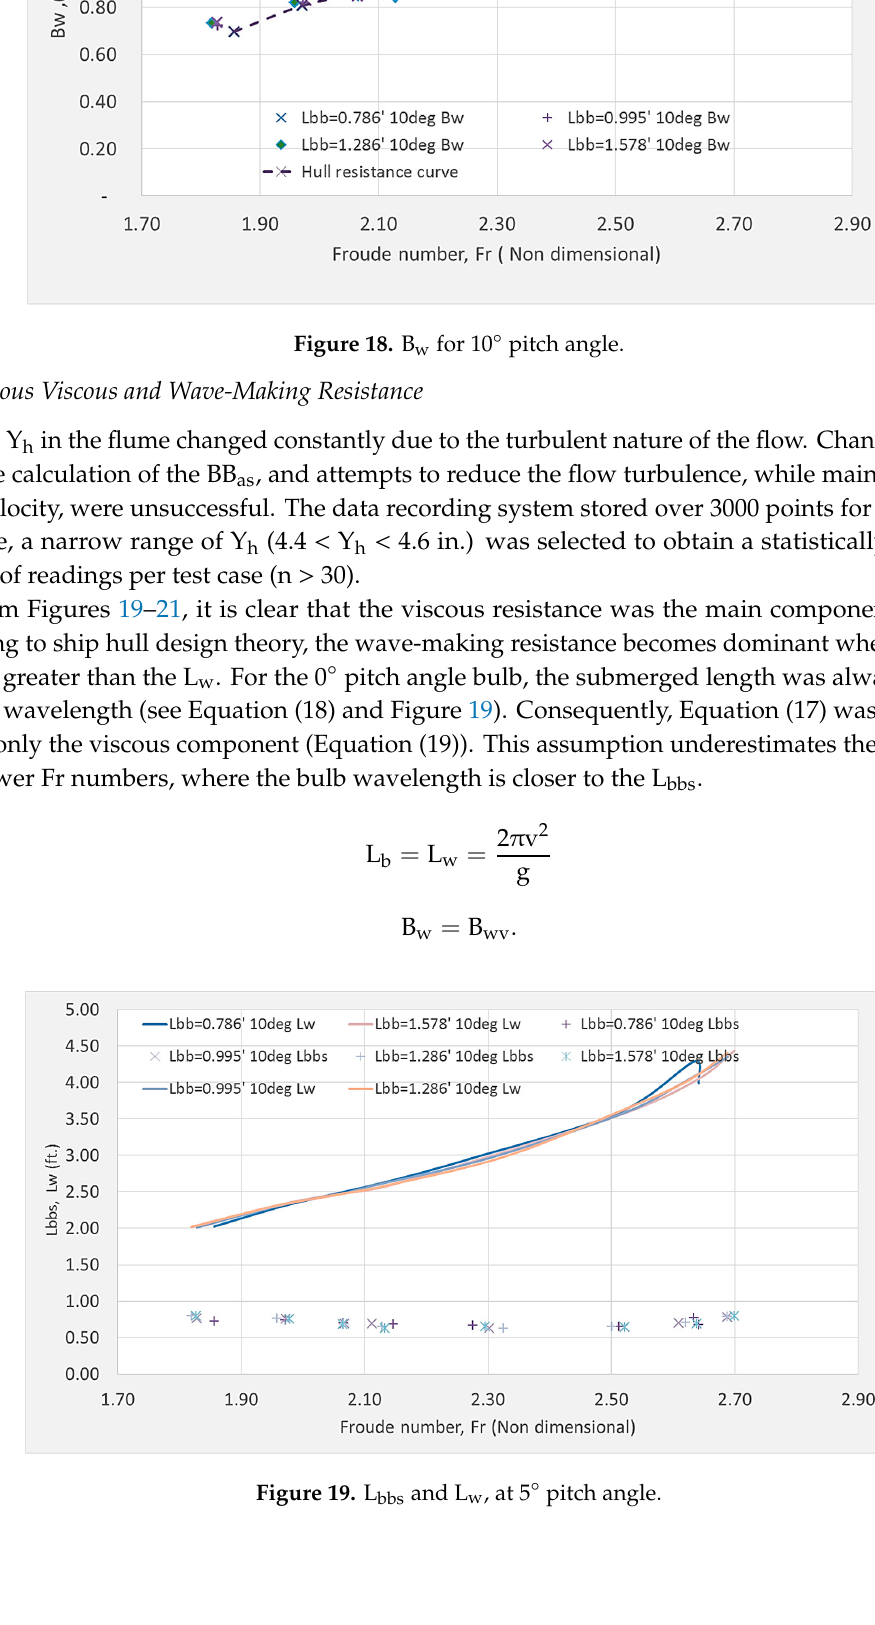
Figure 20. B w , B wv and B ww for the bulbous pier with 5° pitch angle.